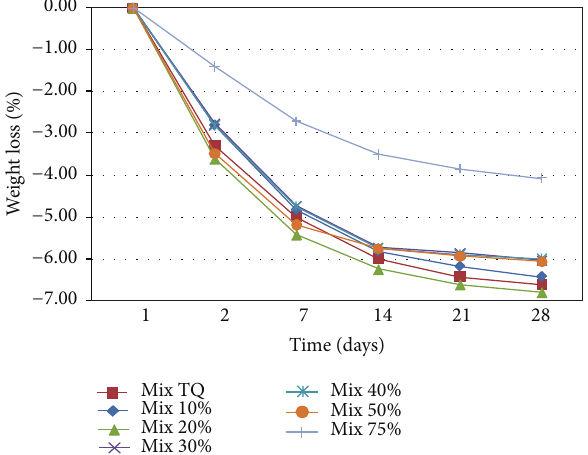
Figure 12: Weigth loss for rubber cement composites at 1, 2, 7, 14, 21, and 28 days ( 𝑇 = 20 ∘ C; U . R . = 50